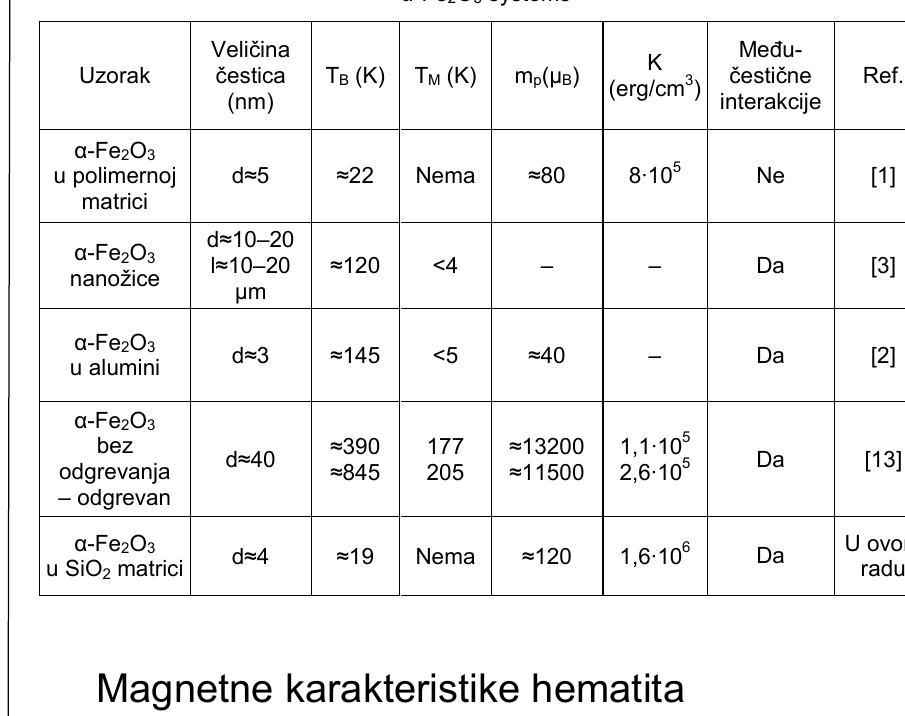
U tabeli 1 možemo uporediti vrednosti dobijene za naš uzorak sa vred- nostima dobijenim u drugim sistemima sa nano č esti č nim hematitom. Sli č nost